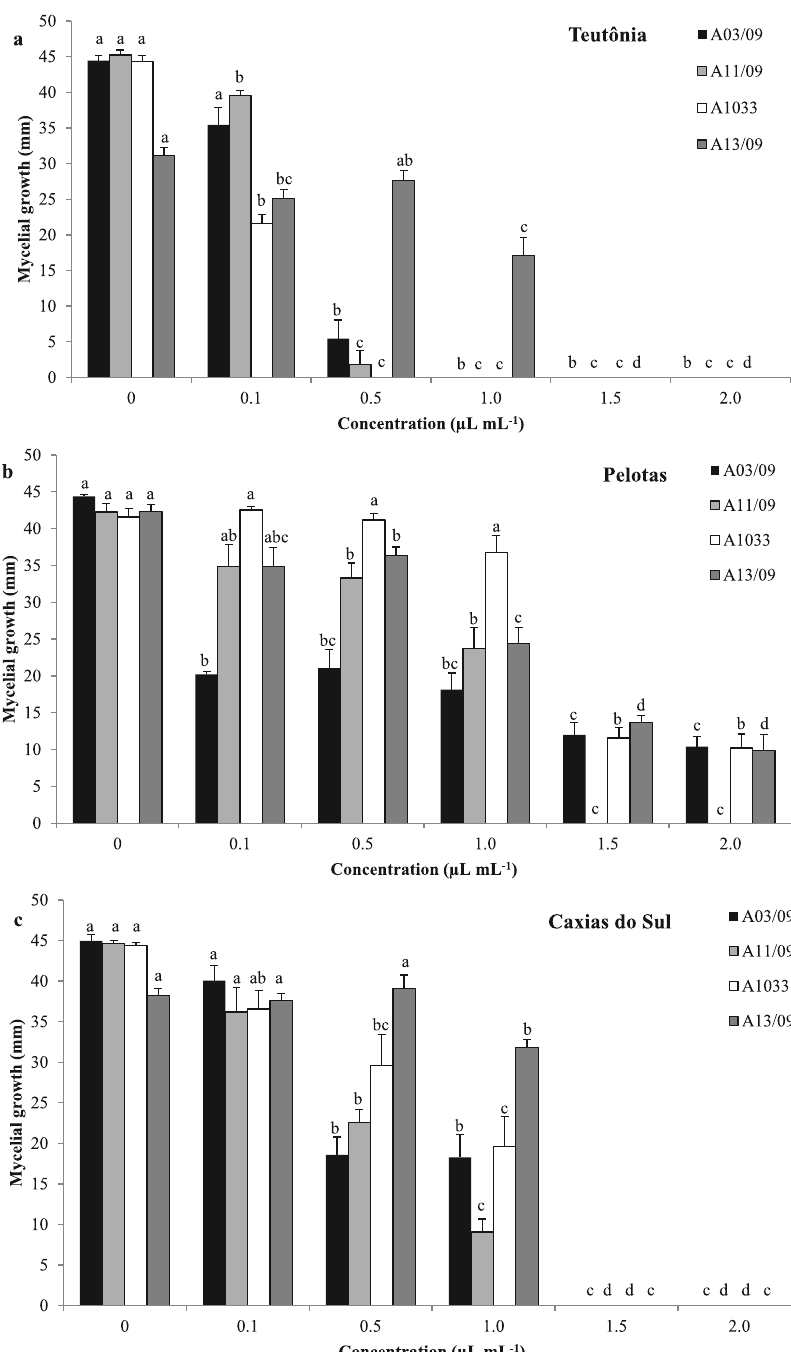
Figure 1 - Effect of different concentrations of three chemotypes of Lippia alba essential oils on the mycelial growth of four Alternaria solani isolates on solid media on the 7 th day. a ) Teutônia accession - citral chemotype, b ) Pelotas accession – camphor/1,8-cineole chemotype, and c ) Caxias do Sul accession – linalool chemotype. Values are the mean of ten replicates. Error bars indicate standard error. Letters indicate the comparison between concentrations for each isolate. Means followed by same letter do not differ regarding the Tukey test (p ≤